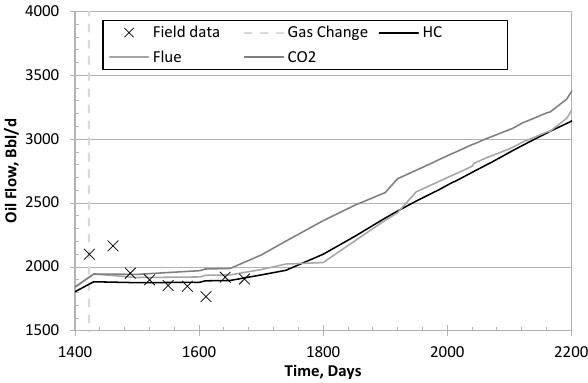
Figure 21. Oil production after different gas injection. Symbols: field measurements; continuous line: baseline.